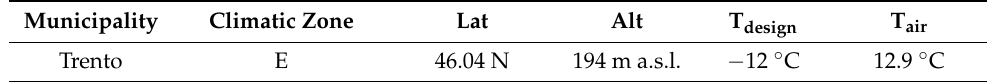
Table 2. Climatic data for the municipality of Trento.